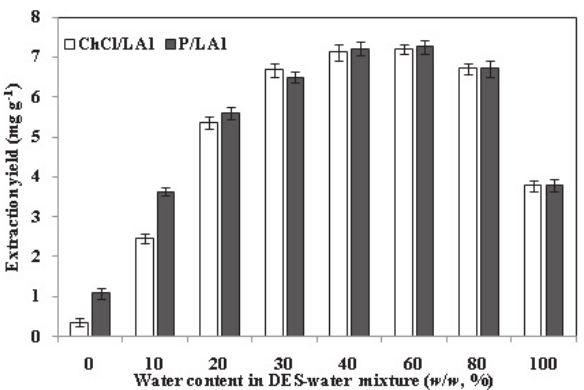
Fig. 1 – Effect of the water content in DES-water mixture on the extraction yield of Ginkgo flavonoids. Varied DES aqueous solution was used as extraction solvent at a solvent to solid ratio of 15:1 with stirring at 25 °C and 150 rpm for 10